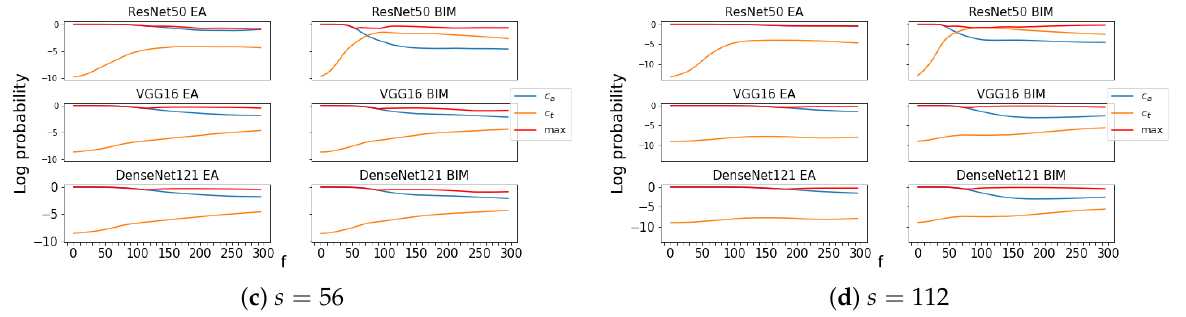
( A 4 ) ( a ) and for sh ( D atk ( A 4 ) , s ) 5 5 6 6